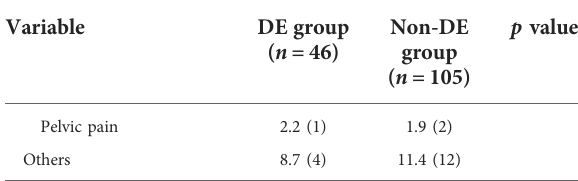
TABLE 1 Comparison of clinical characteristics during the fi rst surgery and the follow-up periods .